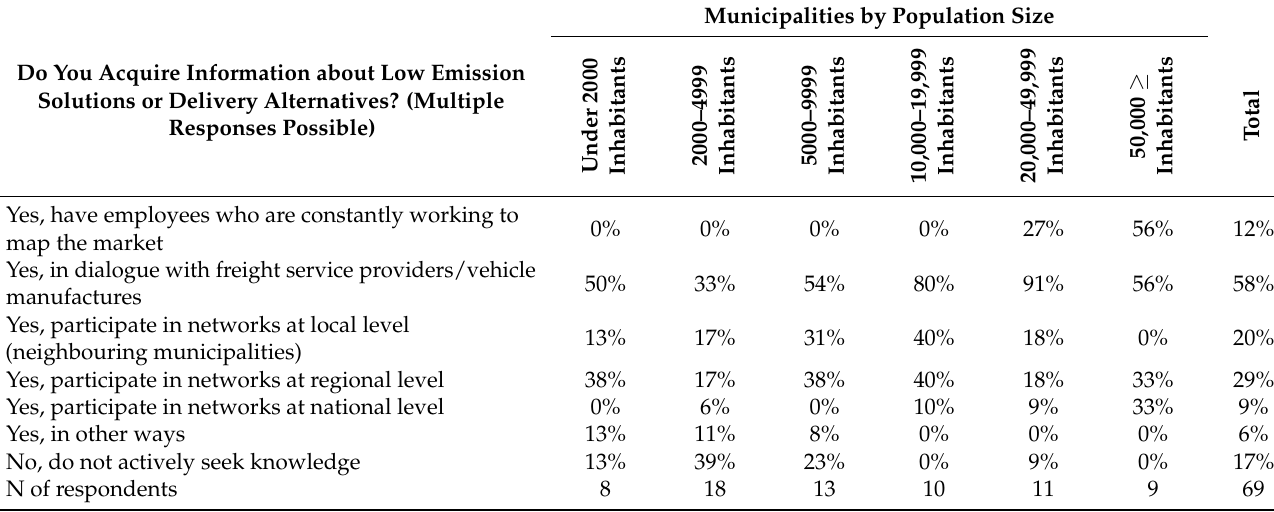
Table 7. How municipalities gain knowledge.